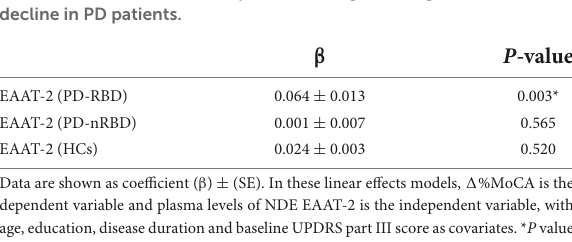
TABLE 3 EAAT-2 and RBD as predictors of global cognitive decline in PD